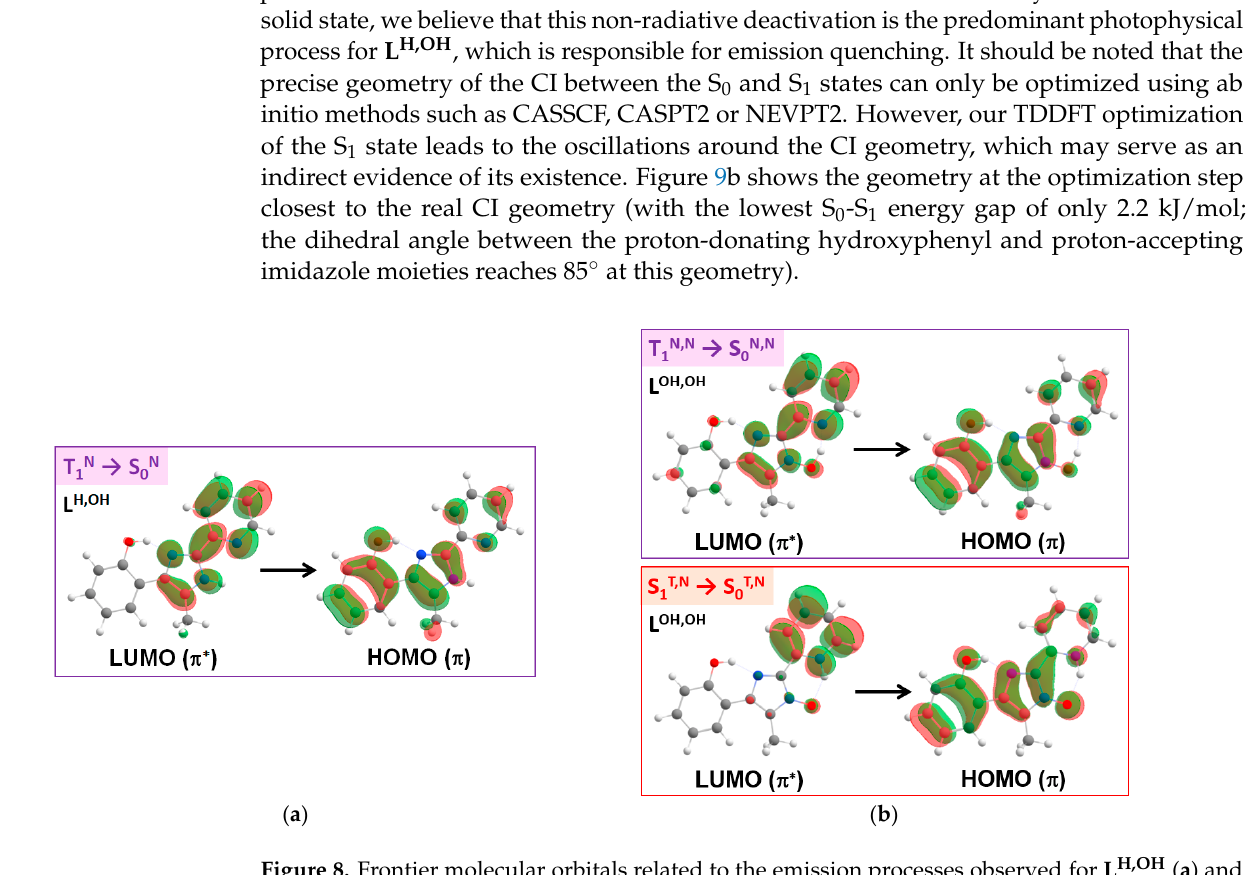
Figure 8. Frontier molecular orbitals related to the emission processes observed for L H,OH ( a ) and L OH,OH ( b ).